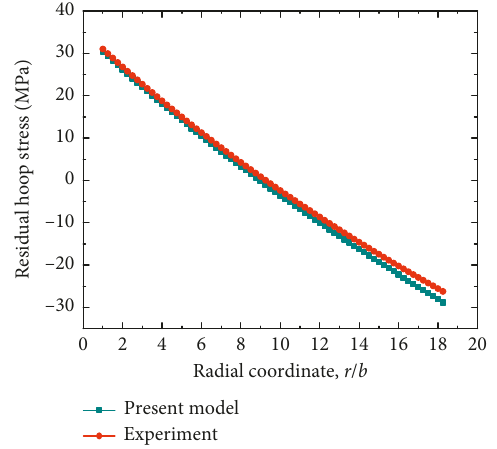
Figure 7: Residual hoop stress of the composite wound cylinder after mandrel removal.